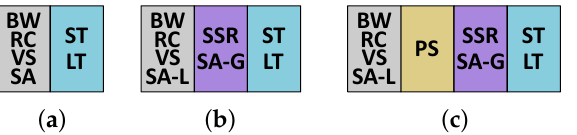
Figure 3. Pipeline of Different NoCs. BW: Buffer Write. RC: Route Compute. VS: Virtual Channel